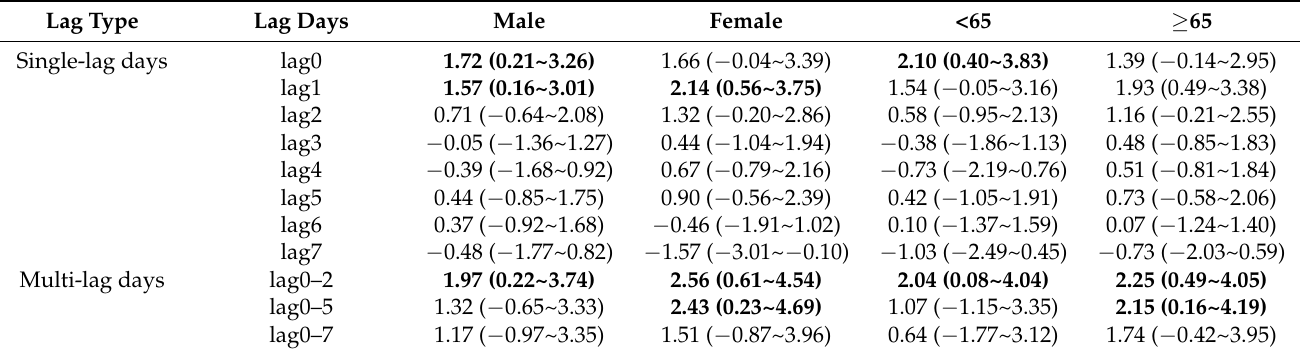
Table 3. Effects of PM 10 on CHD hospitalization risk by gender and age groups, 2019–2021 (ER% (95% CI) for 10 µ g/m 3 increment of PM 10